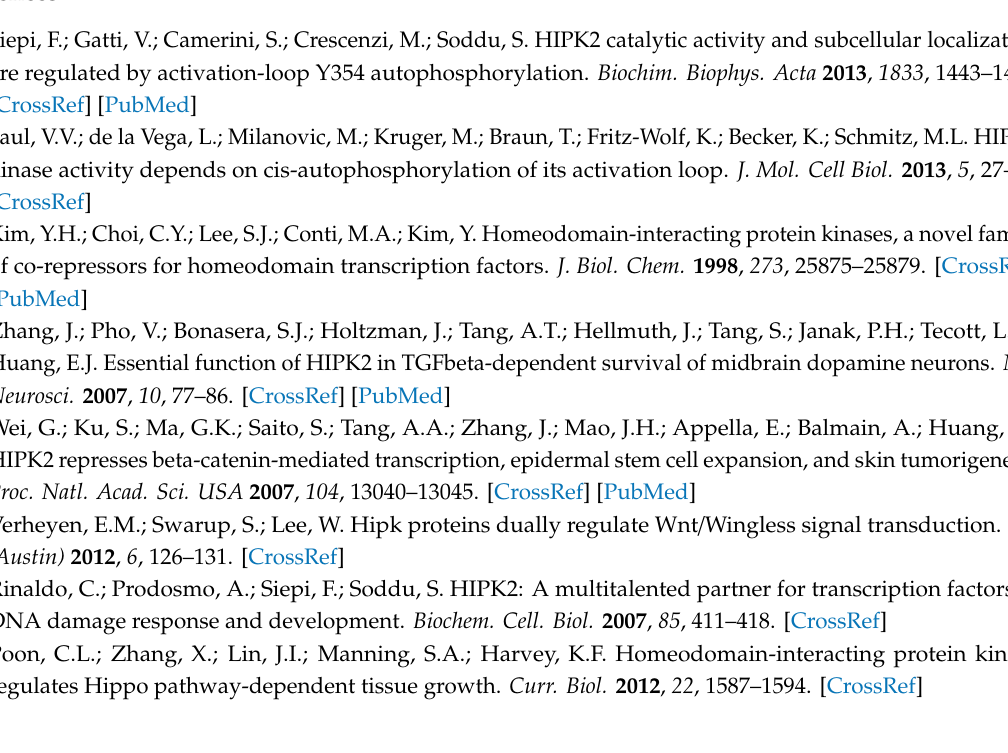
Figure S1: In silico analyses of HIPK2 isoforms, Figure S2: Phylogenesis of the HIPK2-S isoform, Figure S3: HIPK2-S shows a more di ff use nuclear staining than HIPK2-FL, Figure S4: HIPK2 isoforms in DNA damage response, Figure S5: HIPK2-S is required for successful cytokinesis in normal and tumor cells, Figure S6: Anti-HIPK2-S Ab production and validation, Video S1: Time-lapse microscopy of si-Ctr HeLa cells related to Figure 5, Video S2: Time-lapse microscopy of si-FL HeLa cells related to Figure 5, Video S3: Time-lapse microscopy of si-S HeLa cells undergoing binucleation, related to Figure 5 (si-S upper panels). Video S4: Time-lapse microscopy of si-S HeLa cells with long abscission time, related to Figure 5 (si-S lower